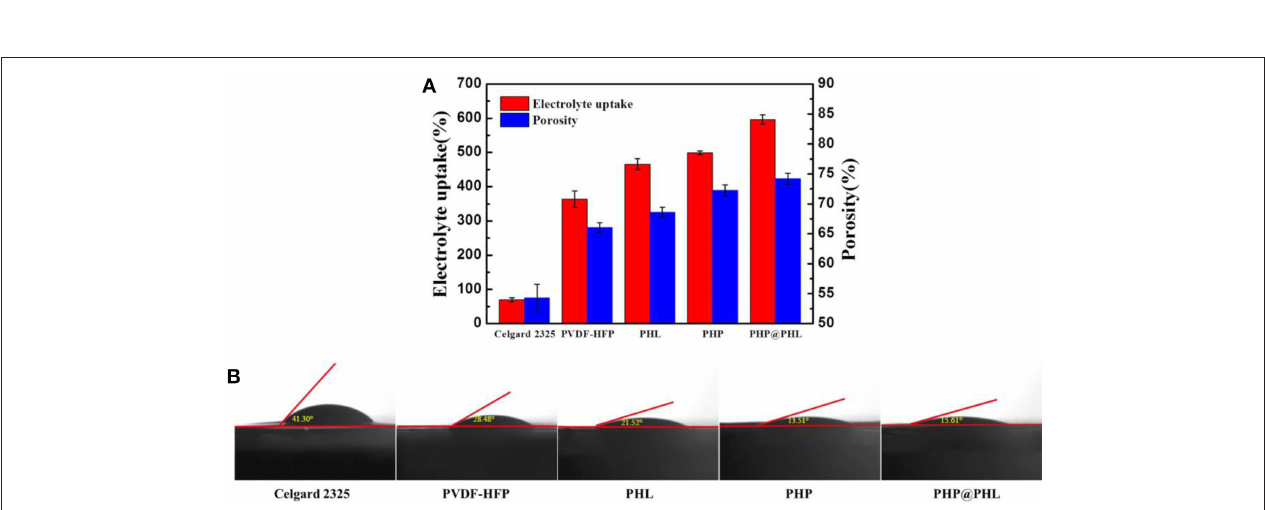
FIGURE 2 | Electrolyte uptake and porosity (A) , as well as the contact angle images with liquid electrolyte droplet (B) of the Celgard 2325, PVDF-HFP, PHL, PHP, and PHP@PHL separators.